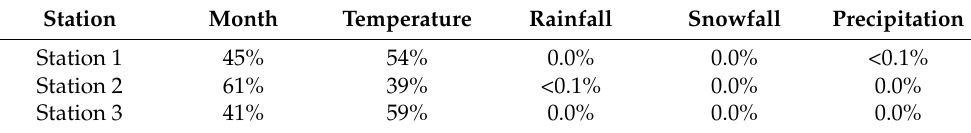
Table 2. The importance of various weather features to the spring freshet model for the three stations.